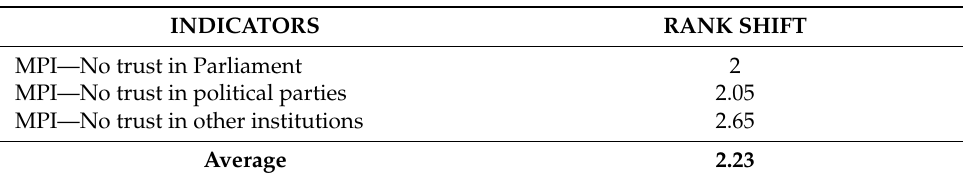
Table 5. The validation of Trust in Institutions Index.